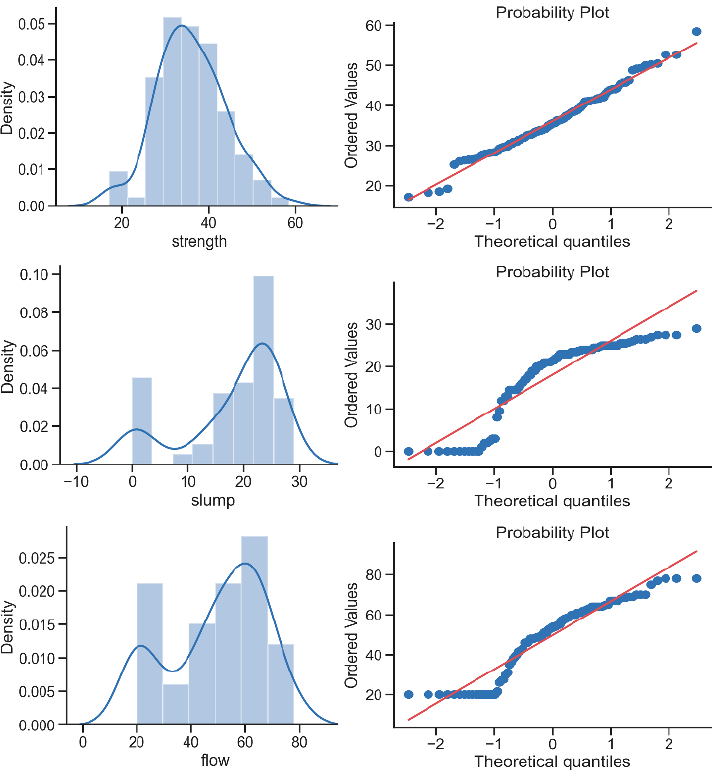
Figure 1. Output variable distribution